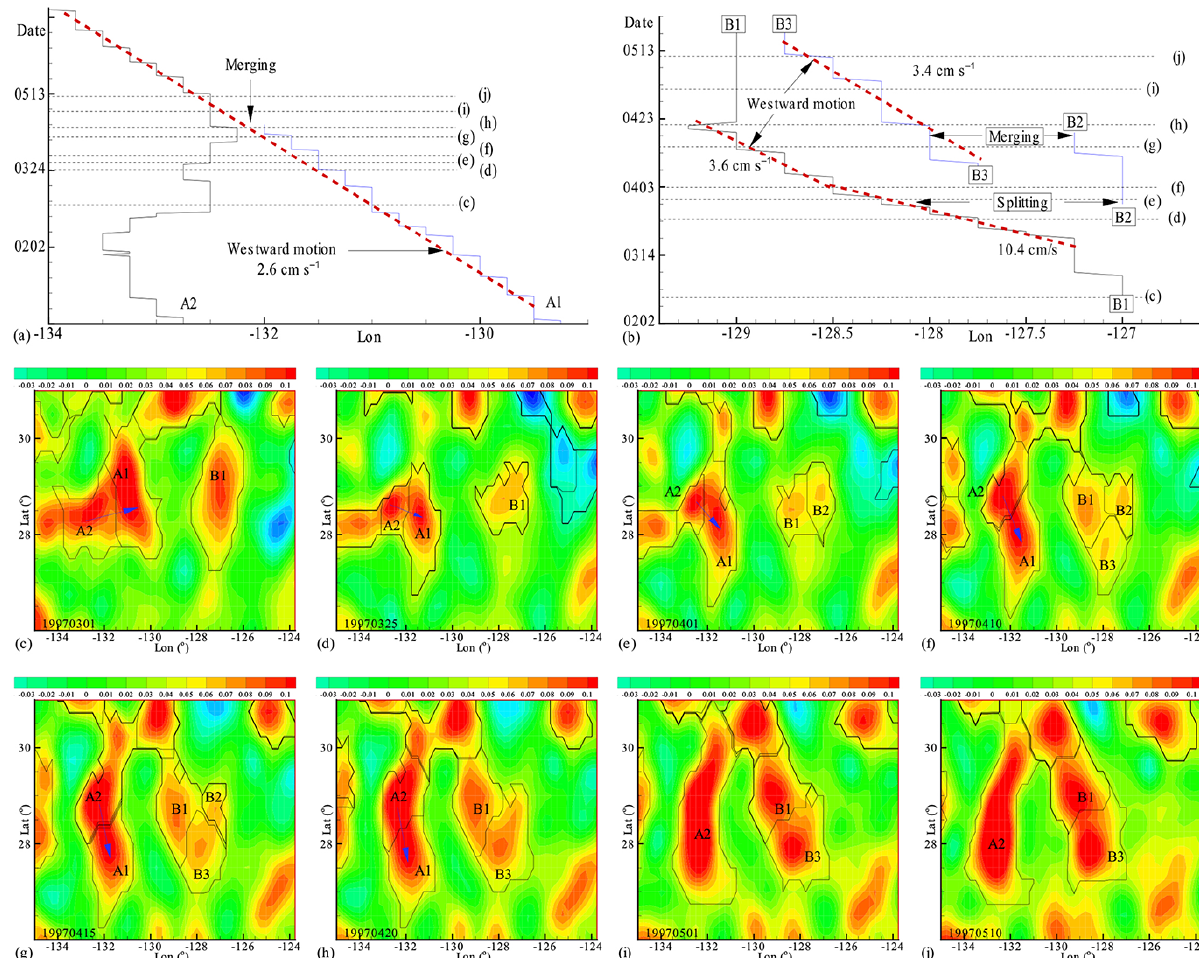
Figure 11. The dynamic evolutions of two groups of eddies, which are located in the red boxes in Fig. 9. (a) Two eddies, A1 and A2, approached each other, and A1 merged with eddy A2, where the blue arrows indicate that the eddy centers rotated clockwise during the merging process. (b) In the meantime, eddy B1 split into two small eddies. (c–j) The evolutions of SLA fields and eddies. Note that eddies A1 and A2 had clockwise rotations when they approached each other, as indicated by the blue arrows in (c) – (h)